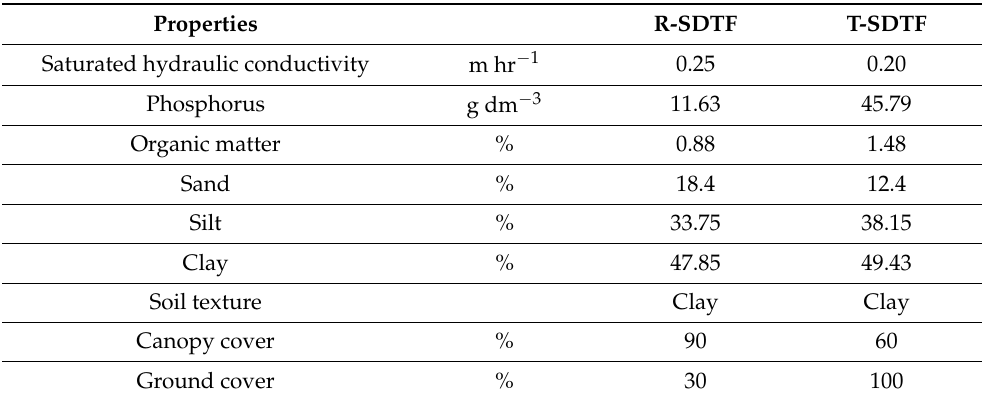
Table 1. Catchment properties for the seasonally dry tropical forest under regeneration (R-SDTF) and seasonally dry tropical forest subject to thinning (T-SDTF) [8].